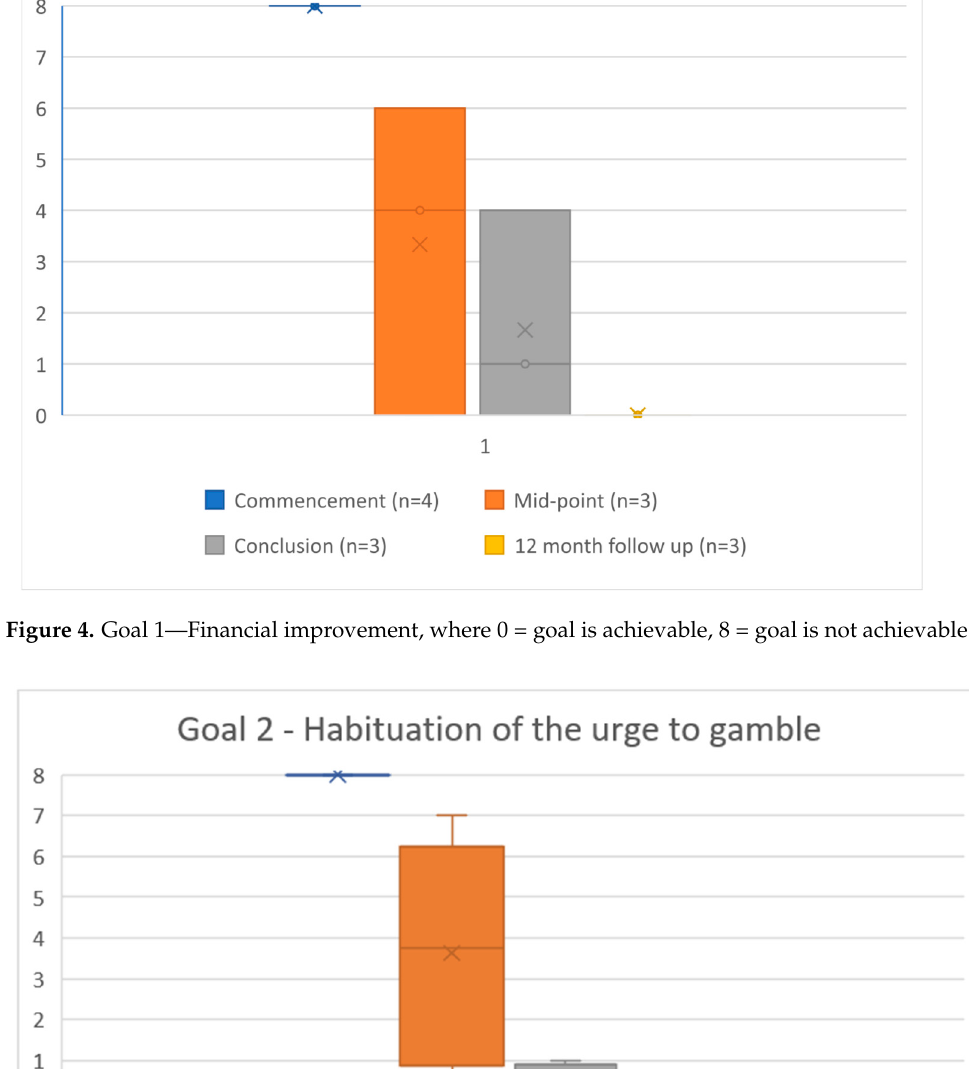
Figure 3. Problem Statement, where 0 = easiest problem to manage, 8 = most difficult problem to manage.